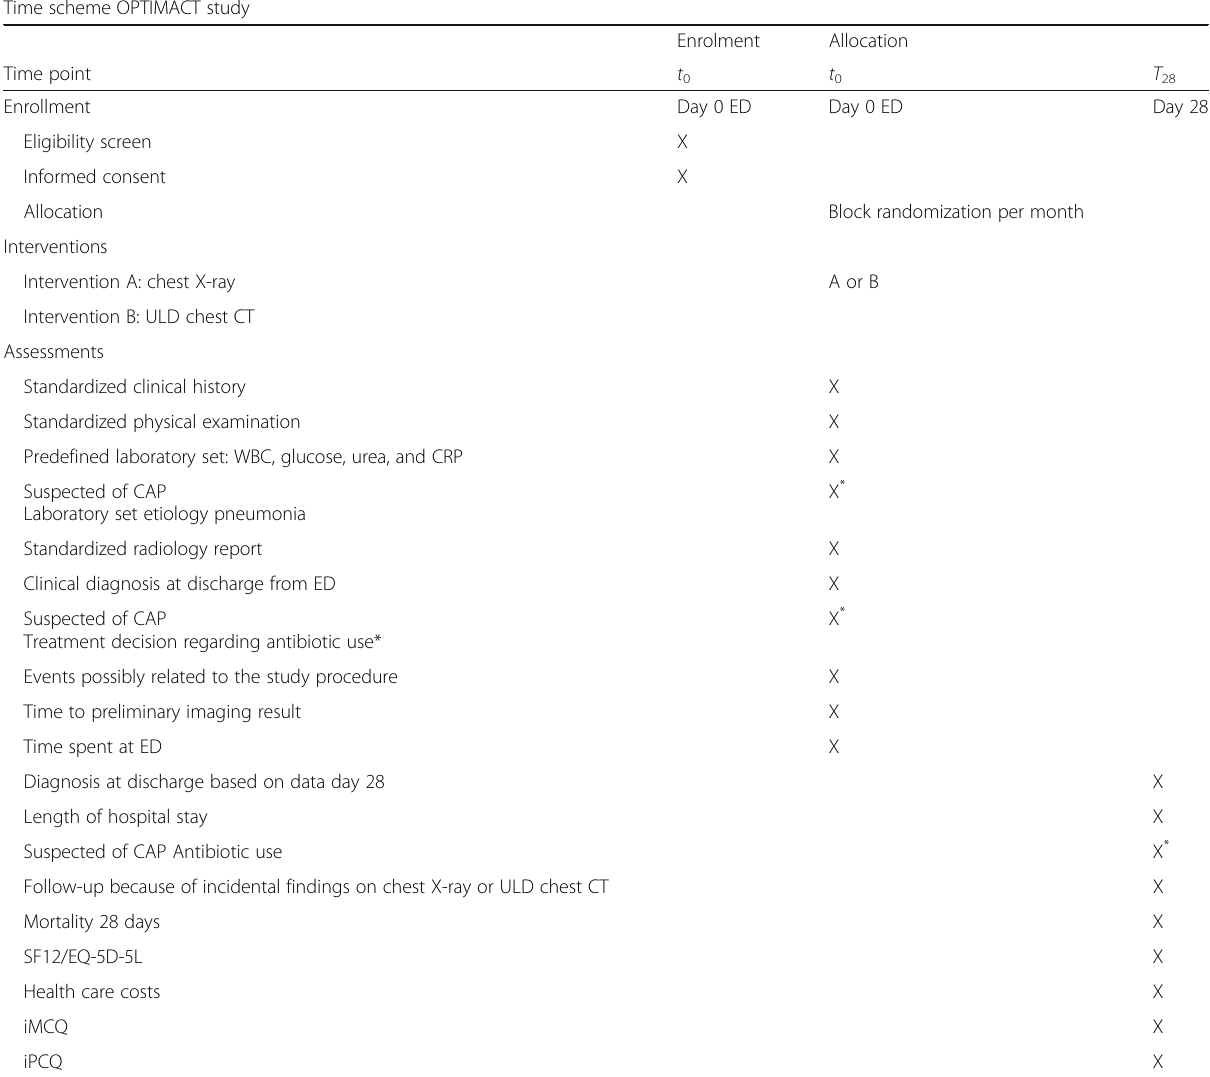
Table 1 SPIRIT OPTIMACT study